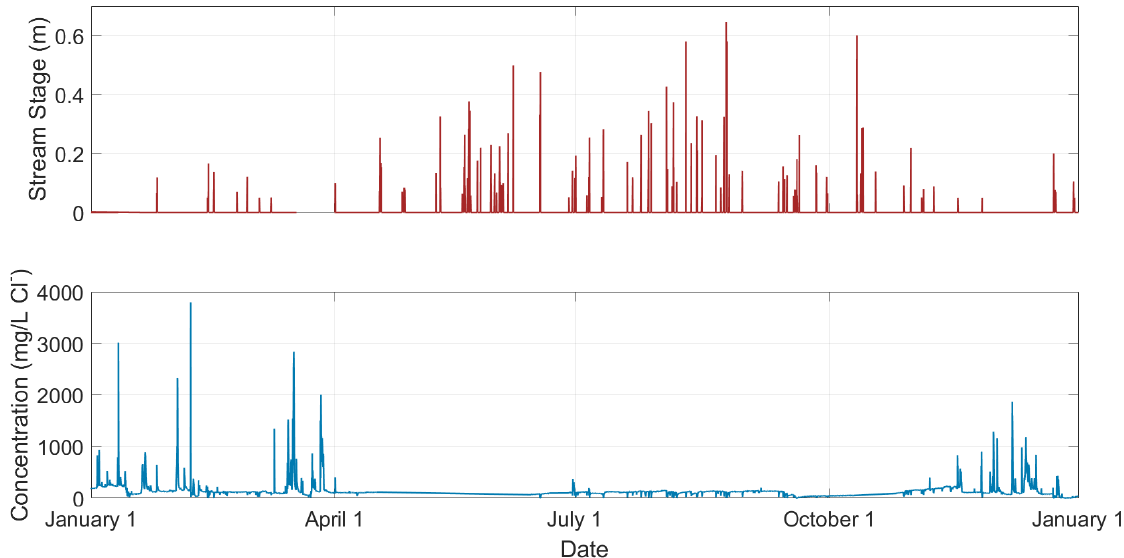
Figure 9. Stream stage–time plot (top panel) and concentration–time plot (bottom panel) from the Varsity Gym (VG) site from 1 January 2018 to 1 January 2019. The salinity data (bottom panel) were scaled by 4.5 to match concentrations observed in the Accidental Wetland and were used in the numerical model as inflow boundary conditions.